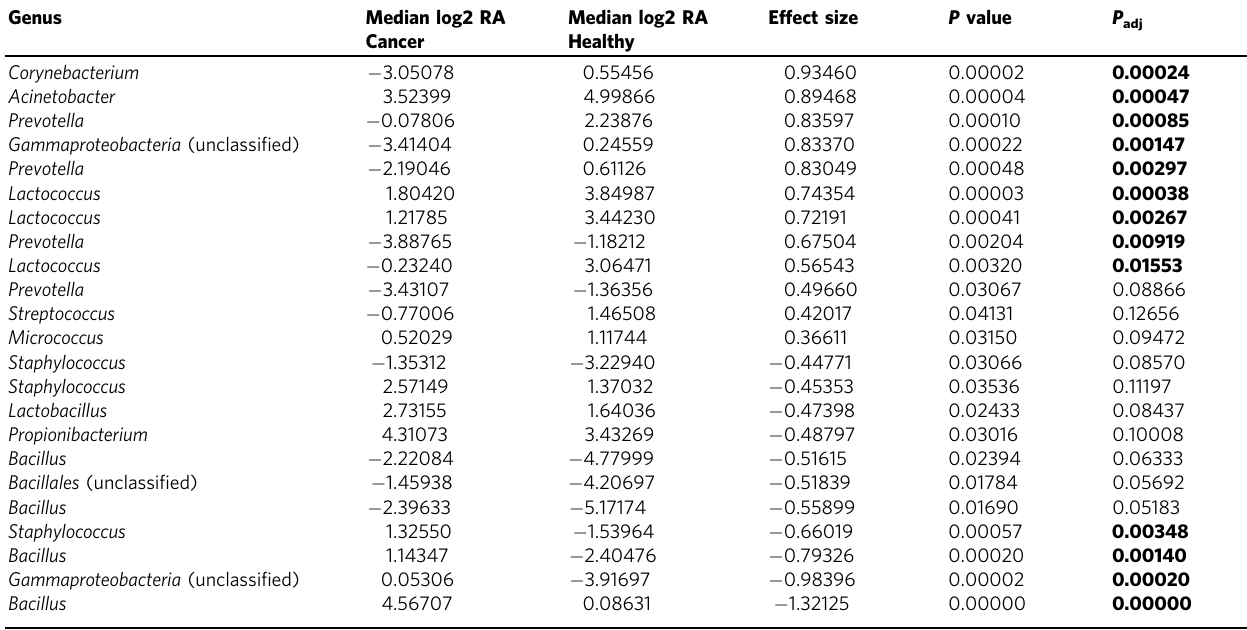
Table 1 Bacterial relative abundances in normal and tumor-adjacent-normal tissue.